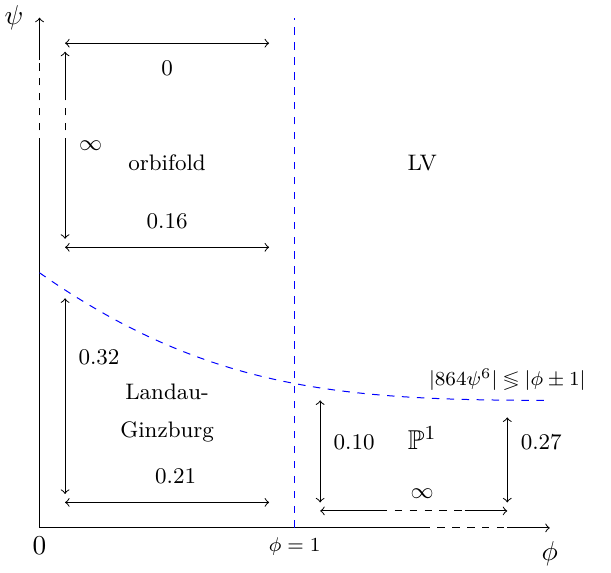
[12] taken from [15]. The 1 , 1 , 2 , 2 , 6 [8] has an 1 , 1 , 2 , 2 , 2